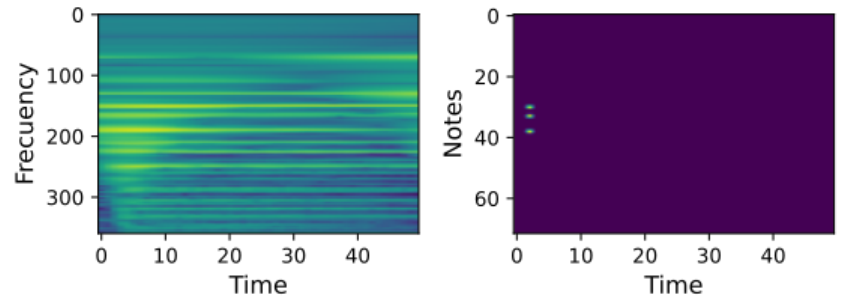
Figure 9. Input to our onsets detection experiment. In the left, the input CQT of the first harmonic obtained as it is explained in Section 2 and in the right, the the onsets representation of pitch (vertical axis) and time frames (horizontal axis) that our model predicts. The horizontal axis of the CQT slice in the left has been rescaled for better